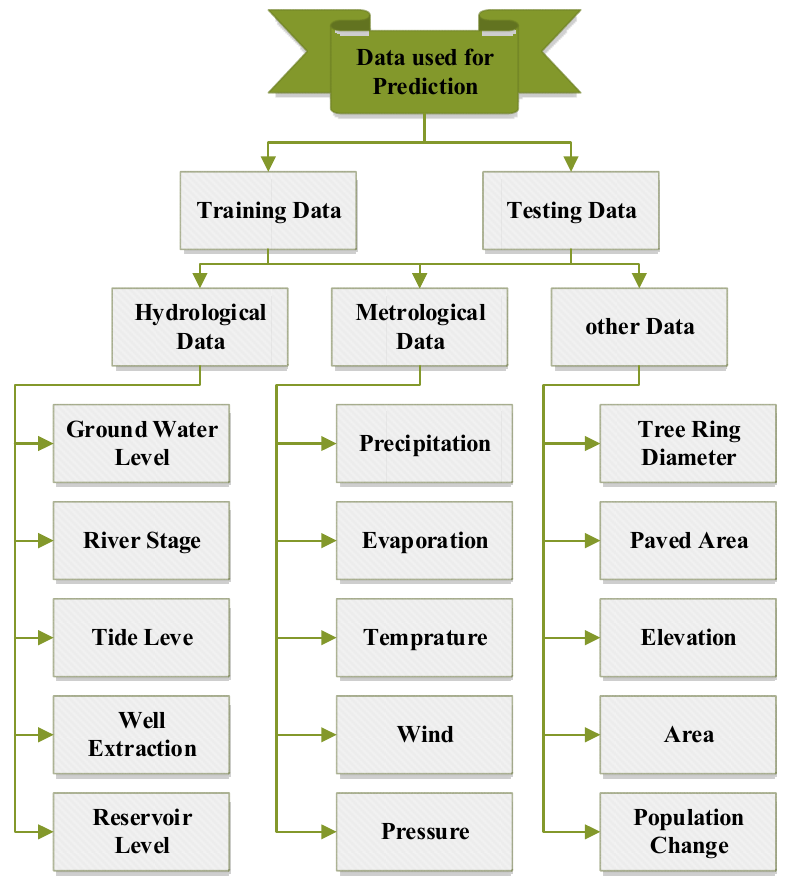
Figure 4. Different kinds of data used for prediction of